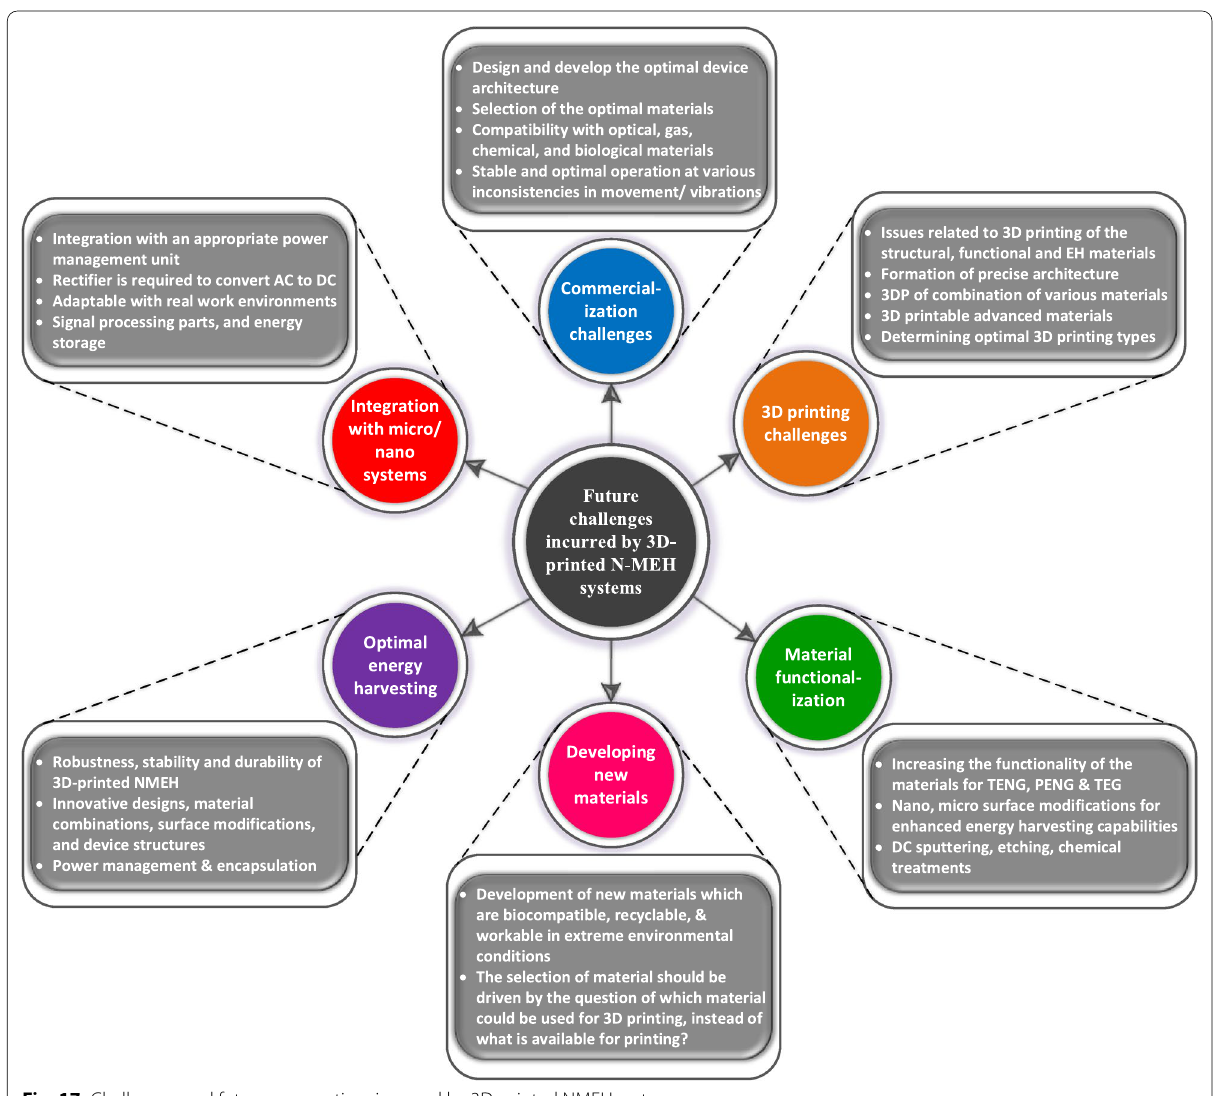
Fig. 17 Challenges and future perspectives incurred by 3D-printed NMEH